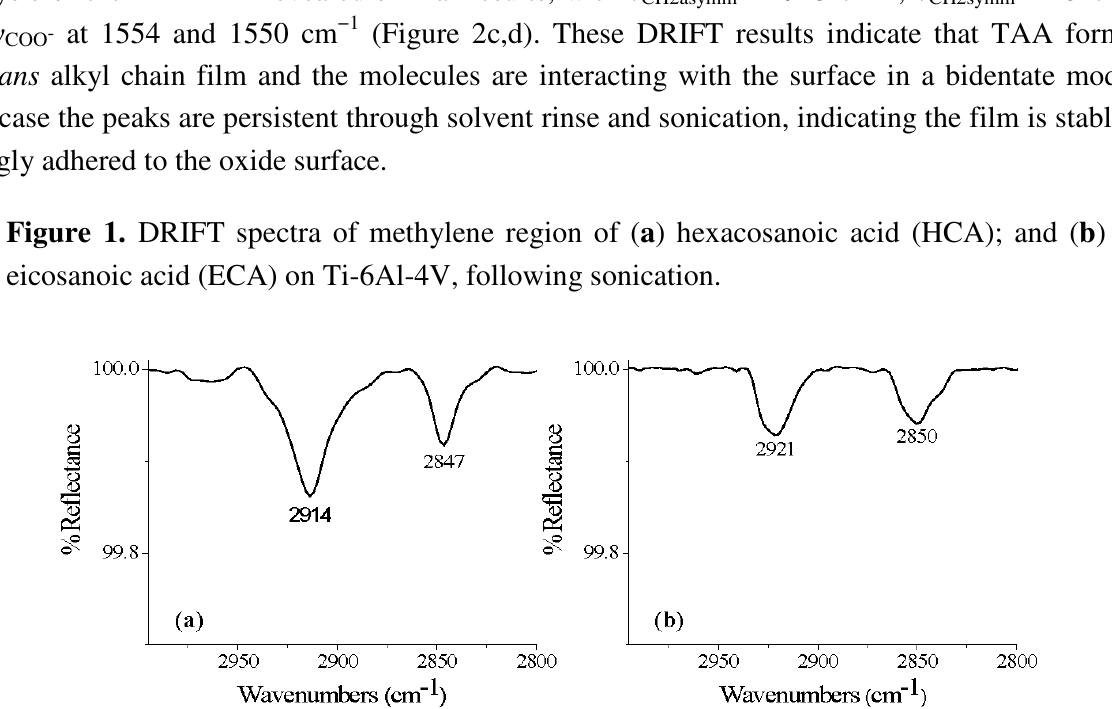
Figure 2. ( a ) DRIFT spectra of OCA methylene peaks; and ( b ) binding region